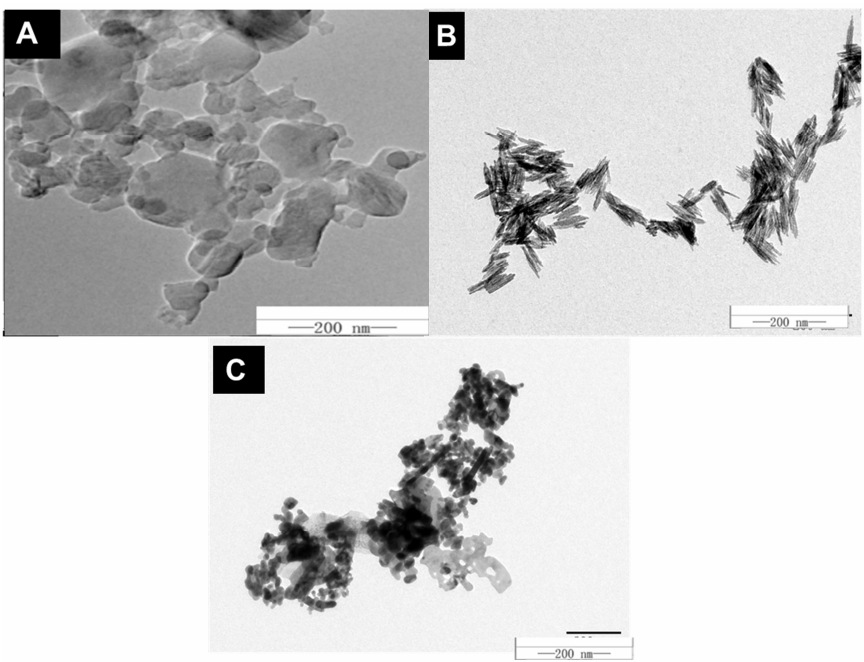
Figure 1. TEM images of C 60 ( A ), Fe ( B ), and Zn ( C ). Each nanomaterial was imaged at a magnification of 107, the scale bar represents 200 nm.